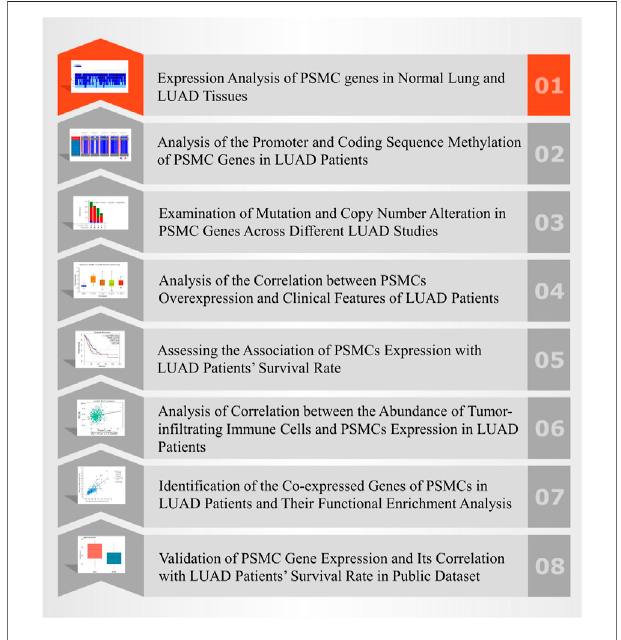
FIGURE 1 | Strategies utilized in the database mining approach employed in the overall